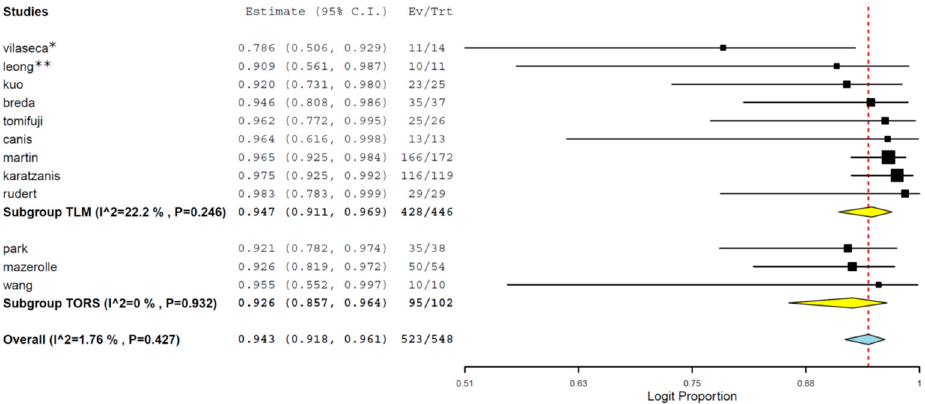
Figure 3. Subgroup meta-analysis including TORS and TLM groups regarding Cumulative Deaths Attributable to Cancer estimates (95% CI).